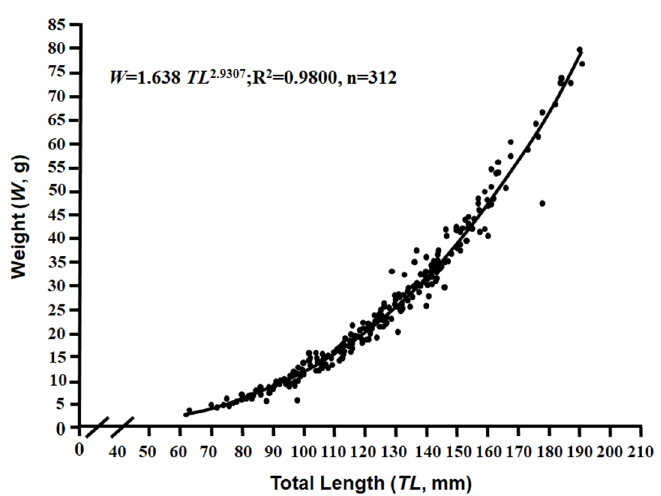
Figure 4. The relationship between body length and body weight of P. penicillatus in Xiamen Bay from 2014 to 2017.